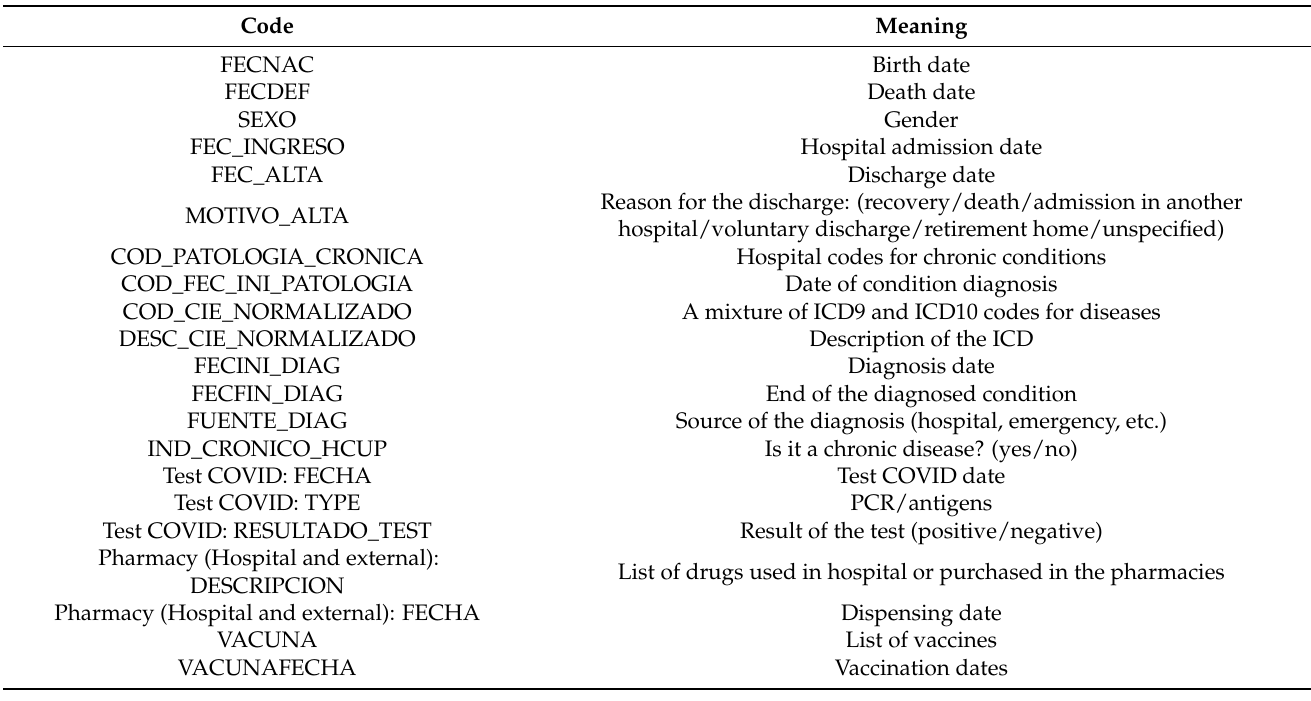
Table 1. Data imported from BPS for each patient: code and definition of the